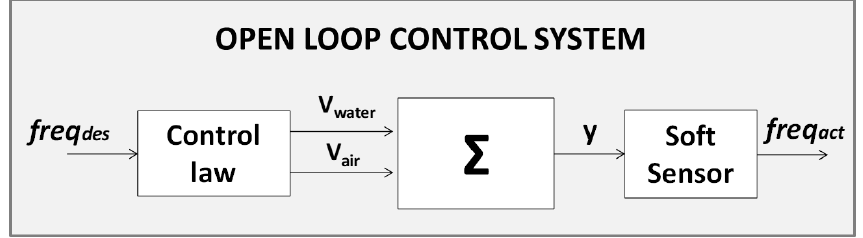
Figure 6. Feed-forward control scheme design.